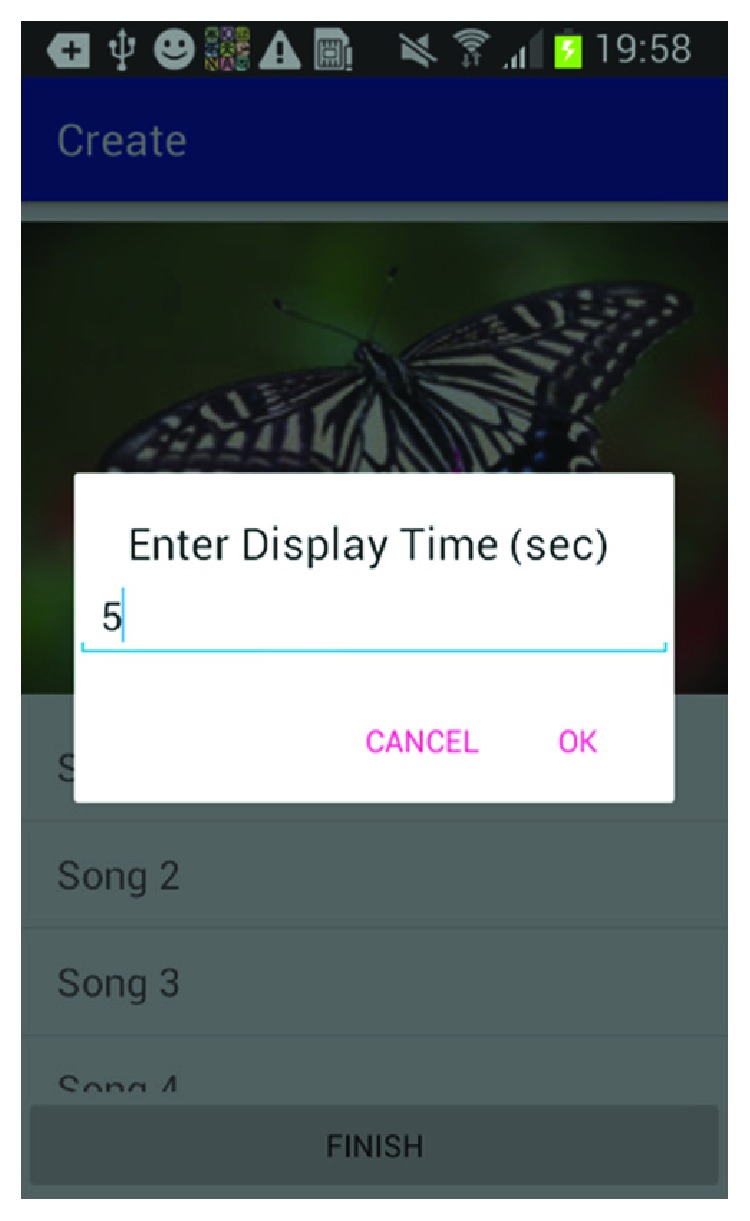
Photo display time.